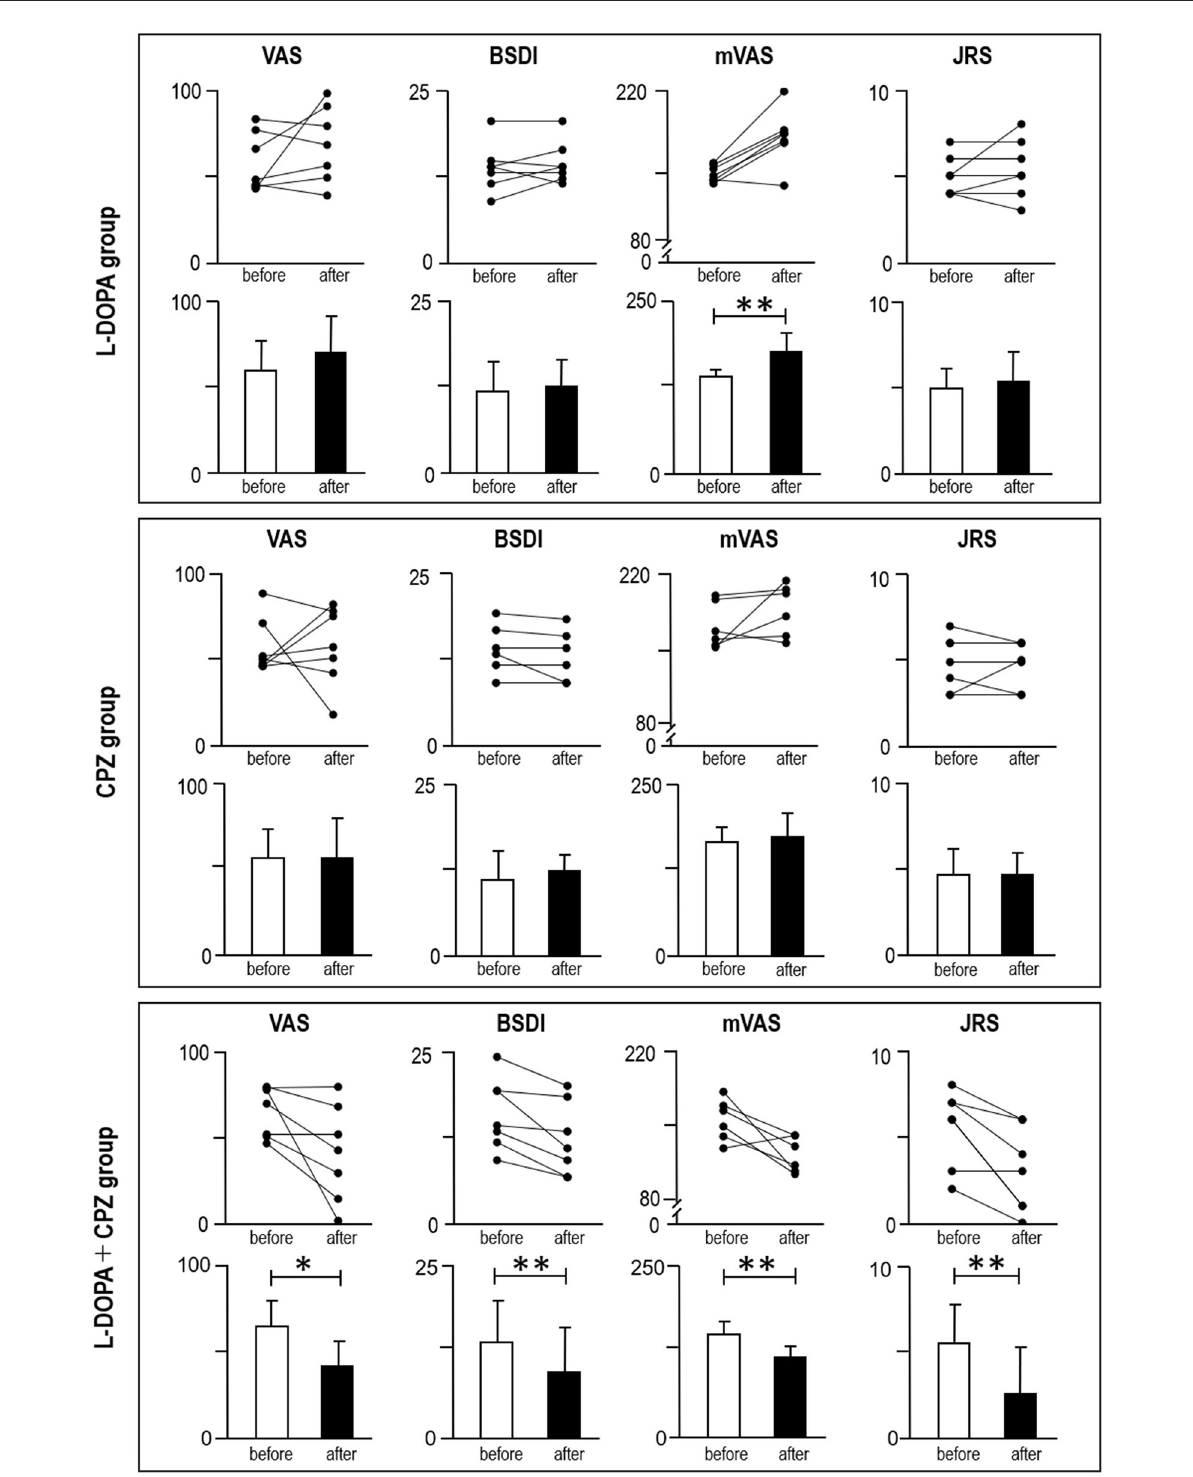
FIGURE3 Measurements of blepharospasm severities before and after the drug challenge test. Symptom severities were determined by using visual analog scale (VAS), Blepharospasm Disability Index (BSDI), modified VAS (mVAS), and Jankovic Rating Scale (JRS). Line plots (upper graphs) and average plots (lower graphs) are shown in the “L-DOPA group ( n = 7)” (top panel), “CPZ group ( n = 7)” (middle panel), and “L-DOPA + CPZ group ( n = 7)” (bottom panel). * P < 0.05, ** P < 0.01 (“before” vs. “after”, Wilcoxon signed-rank